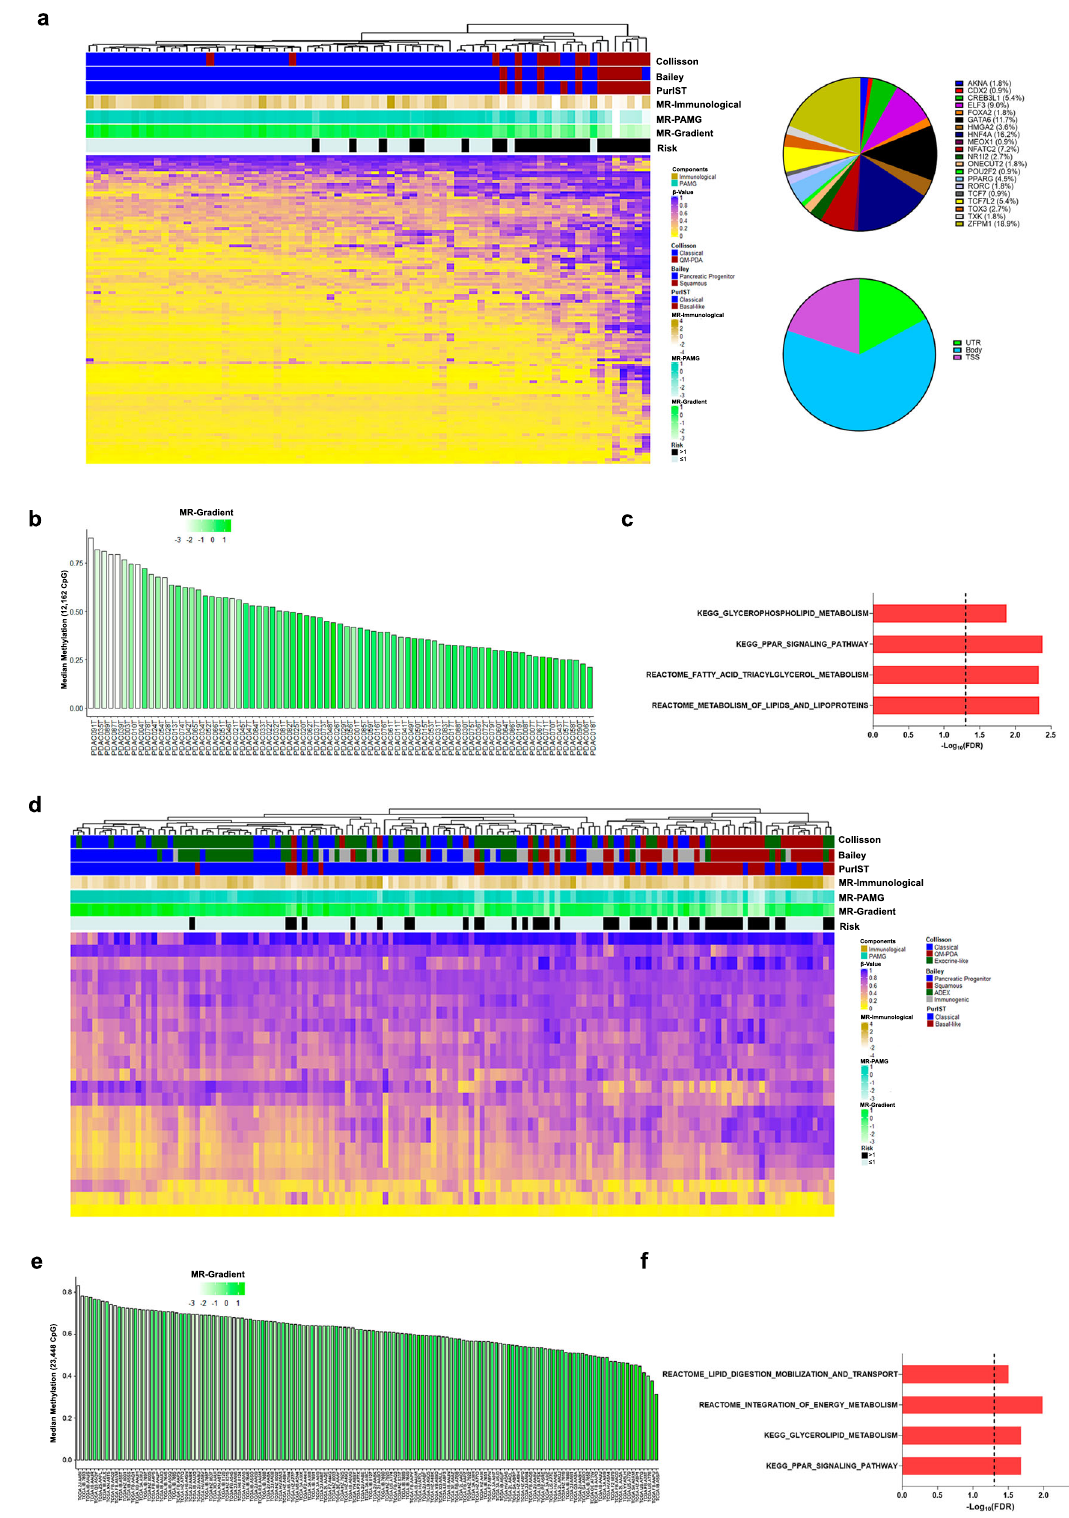
Fig. 4 Association of the CpGs methylation pro fi le with the MR-gradient. a The master regulators associated with a favorable prognosis showed a negative correlation between the methylation level and MR-Gradient. b Globally the unfavorable prognosis phenotype was associated with a hypermethylation pro fi le of the ICA high contributive CpGs. c ICA high contributive CpGs were associated mainly with lipid metabolic pathways. d Master regulators related to a favorable prognosis displayed a hypermethylated pro fi le in the unfavorable prognosis patients in the TCGA-PAAD cohort. e The global methylation level showed a negative correlation with the MR-Gradient in the TCGA-PAAD cohort. f ICA high contributive CpGs were associated with metabolic pathways in the TCGA-PAAD cohort.